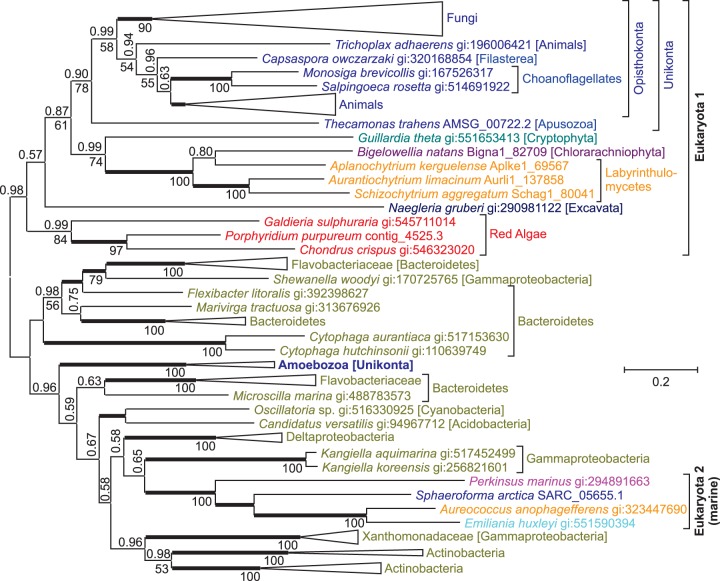
An evolutionary tree for kynurenine-3-monooxygenase indicates that some unicellular eukaryotes acquired genes through horizontal transfers. The unrooted Bayesian tree shows posterior probabilities above the branches and PhyML bootstrap values below the branches. Thickened horizontal lines represent 1.0 Bayesian posterior probability. Trees with significantly lower log-likelihood were obtained when monophyly was enforced for all sequences from eukaryotes, from Amoebozoa plus other Unikonta (without Sphaeroforma arctica), from S. arctica plus other Opisthokonta, or from Emiliania huxleyi, Aureococcus anophagefferens, and Perkinsus marinus plus Labyrinthulomycetes and Chlorarachniophyta (i.e., SAR and Haptophyta; fig. 2 and supplementary table S1, Supplementary Material online).